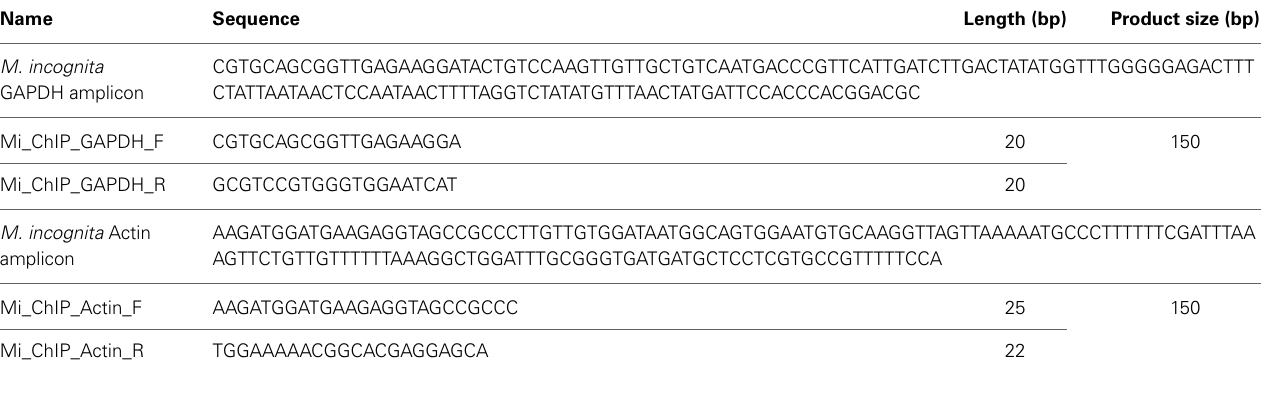
Table 2 | Amplicon sequences and primer sequences designed for